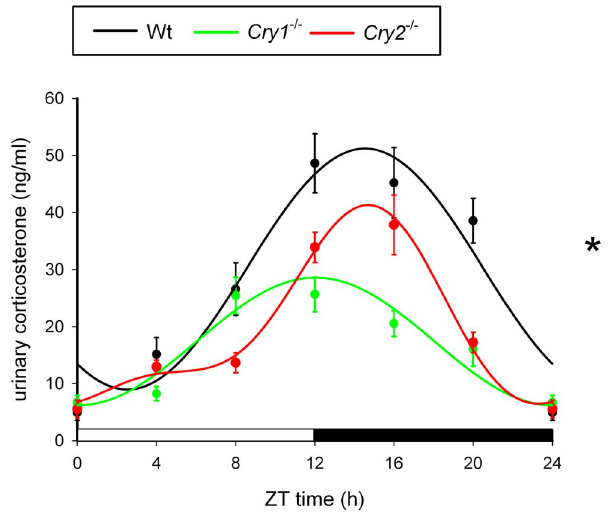
Figure 6. Circadian profiles of urinary corticosterone in Cry1 -/- and Cry2 -/- mice. Urine was collected at 4 h intervals over a 24 h period and corticosterone levels were determined. Shown are the mean urinary corticosterone concentrations for male wild type (black), Cry1 -/- (green), and Cry2 -/- (red) mice ( 6 s.e.m; n=8 per genotype). Data were fitted with a wave curve and analysis of variance revealed significant difference among genotypes (p , 0.001). Data at ZT0 and ZT24 are double-plotted for easier visualization of daily expression. The bar below panel indicates lights on and off.